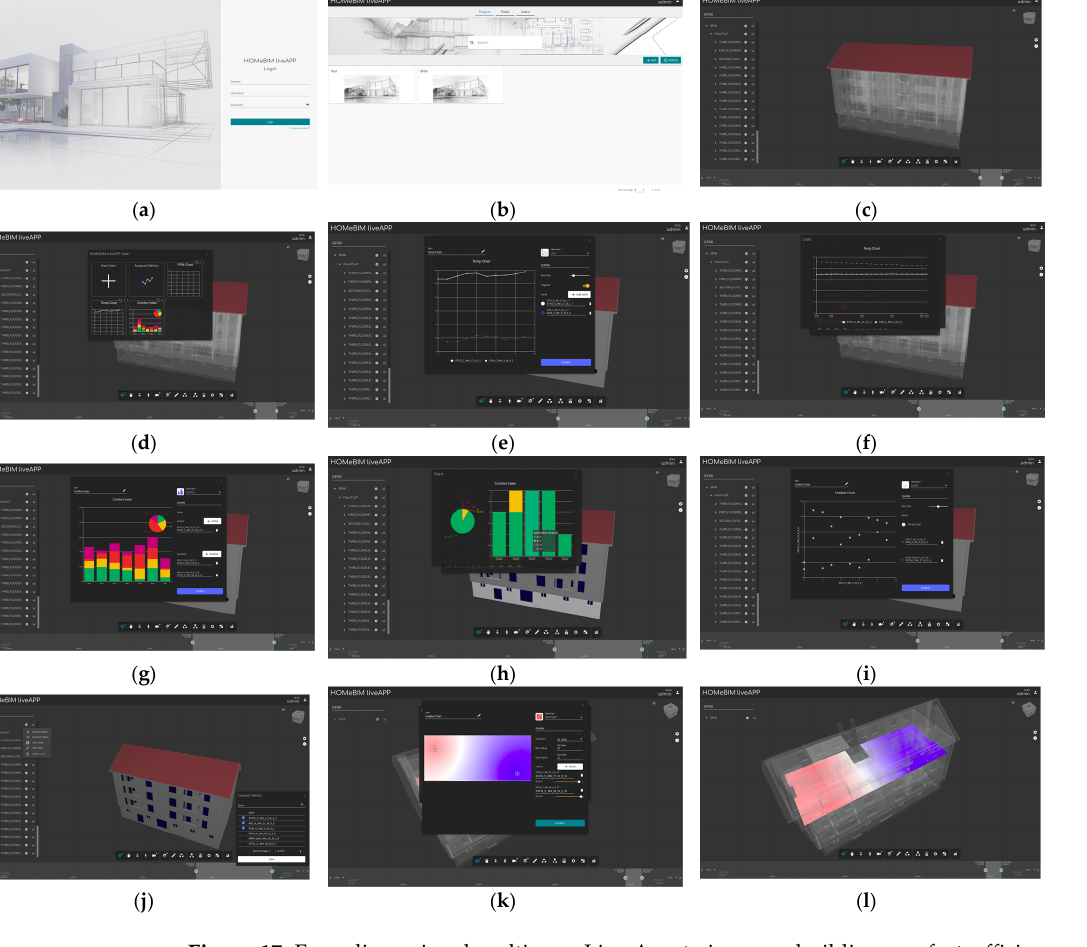
Figure 18. Four-dimensional multi-user live app: mobile version (phone and tablet). 6. Discussion